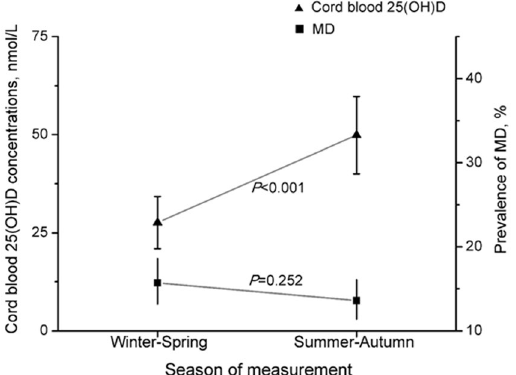
Figure 1. Maternal depression (MD) and newborn concentrations of 25(OH)D across the seasons. MD was defined as the scores of Center for Epidemiological Studies Depression Scale greater than a clinically significant cutoff score of 16. Bars represent the mean and 95% CI of the mean.